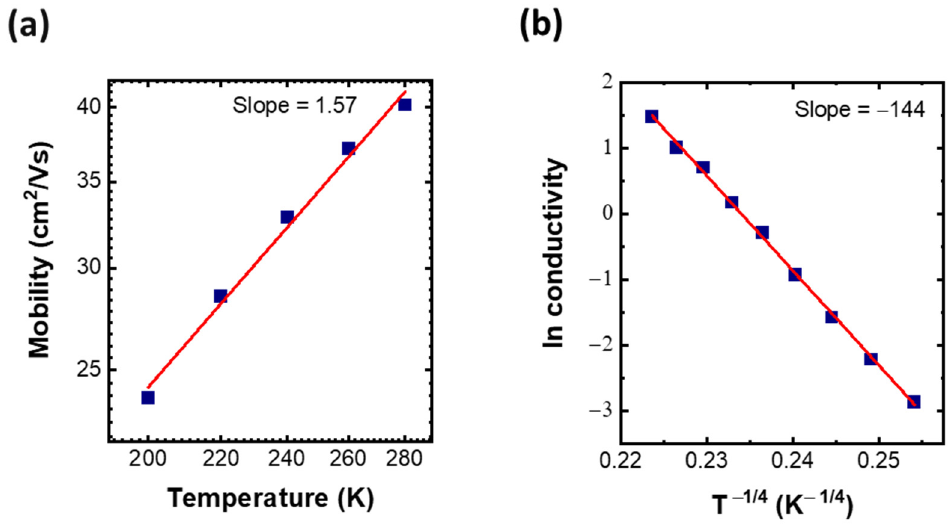
Figure 5. ( a ) log–log plot of hole mobility vs. temperature for 250 nm GaSb on SiO 2 over temperature range of 200–280 K, and ( b ) plot of ln conductivity vs. T − 1/4 for 50 nm GaAs + 50 nm GaSb on SiO 2 .